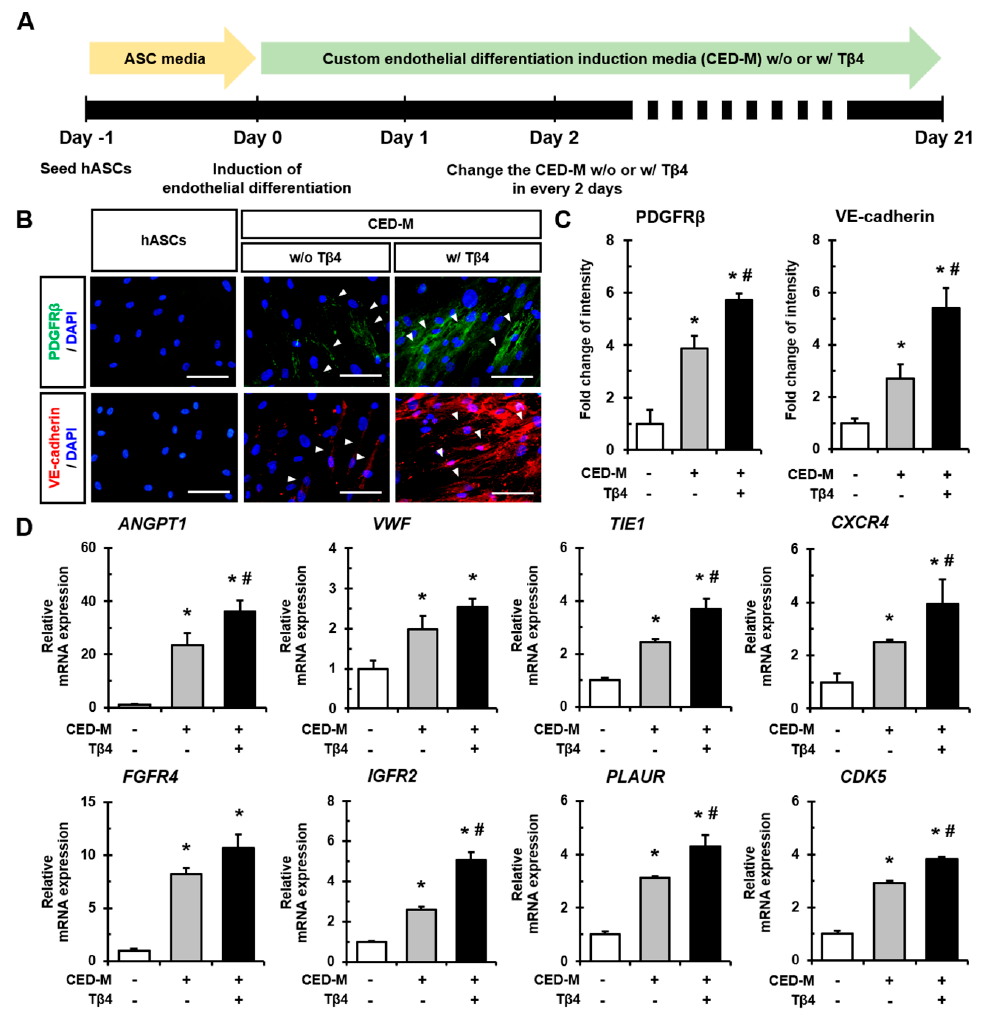
Figure 3. Additional treatment with T β 4 enhances endothelial di ff erentiation of hASCs. ( A ) Schematic diagram showing the induction of endothelial di ff erentiation of hASCs using CED-M and additional T β 4 treatment for 21 days. ( B ) Representative immunofluorescence images of PDGFR β and VE-cadherin after inducing endothelial di ff erentiation without or with T β 4 treatment. White arrowheads indicate positive expression of PDGFR β and VE-cadherin. Scale bar = 100 μ m. ( C ) Quantitative analysis of fluorescence intensities of PDGFR β and VE-cadherin. * p < 0.05 vs. CED-M - / T β 4 - ; # p < 0.05